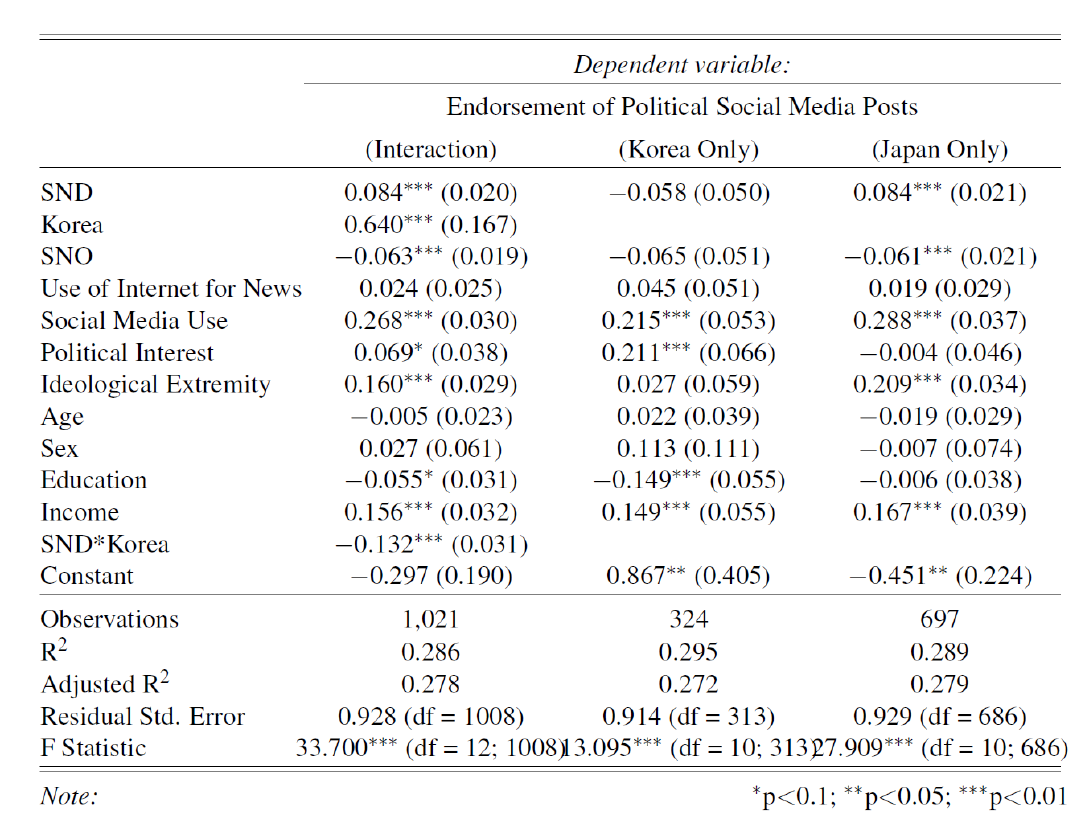
Table 3. The Relationship between SNO, SND, and Endorsing